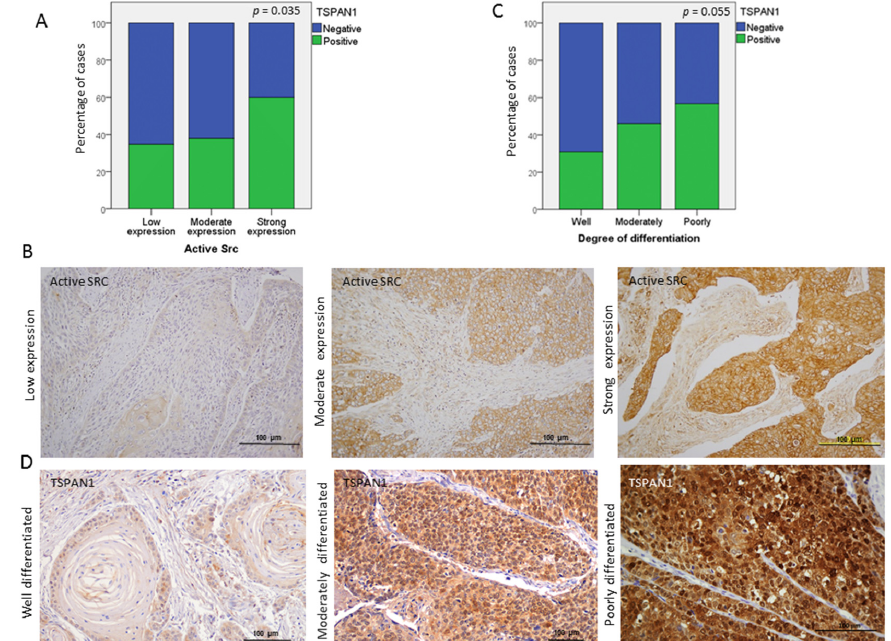
Figure 6. Protein expression study of TSPAN1 in human biopsies from HNSCC patients. ( A ) Western blot of TSPAN1 protein in laryngeal and pharyngeal cancer biopsies comparing tumor (T) vs. normal tissue (N). ( B ) Representative images of IHC staining for TSPAN1 and E-Cadherin proteins. The expression of TSPAN1 was only observed in the tumor tissue, showing either a cytoplasmic or a cytoplasmic and nuclear pattern. ( C ) Table summarizes the percentage of patients with positive expression for the indicated proteins in the studied cohort of 106 HNSCC patients. ( D ) Correlation between E-Cadherin and TSPAN1 expression. The plots show the expression of cytoplasmic TSPAN1 (upper panel) and nuclear TSPAN1 (lower panel). χ ² test and Fisher’s exact test.